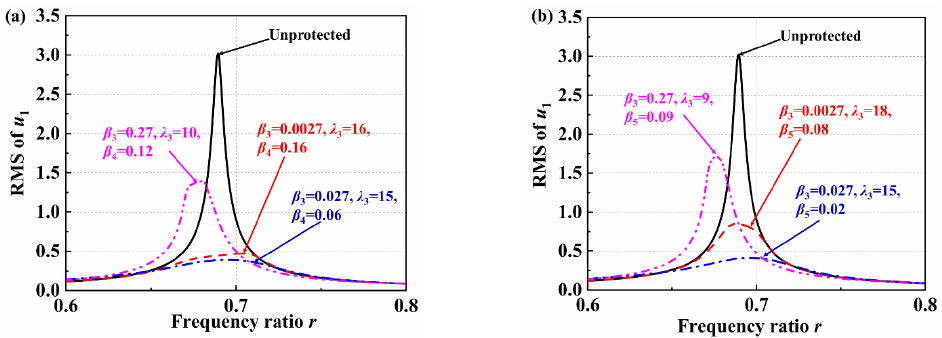
Figure 10. The root-mean-square of u 1 based on the values of the optimal parameter: ( a ) β 4 ; ( b ) β 5 .